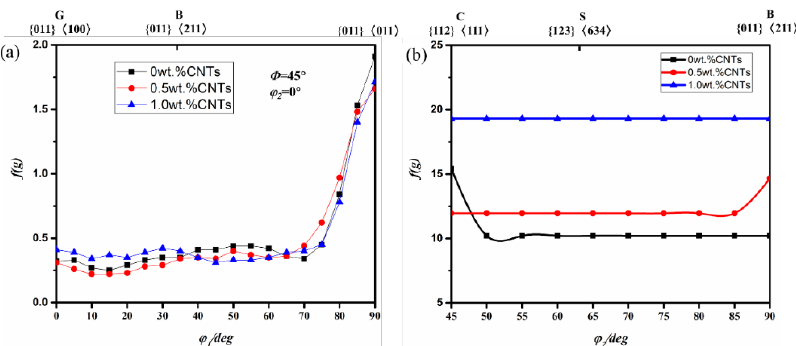
Figure 8. Orientation density f (g) of Al with 0, 0.5, 1.0 vol.% CNTs nanocomposites. ( a ) α orientation line ( b ) β orientation line.